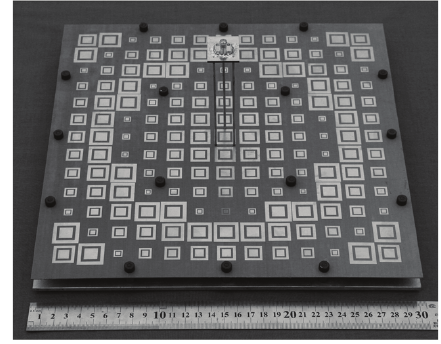
Figure 6: Prototype of the antenna.